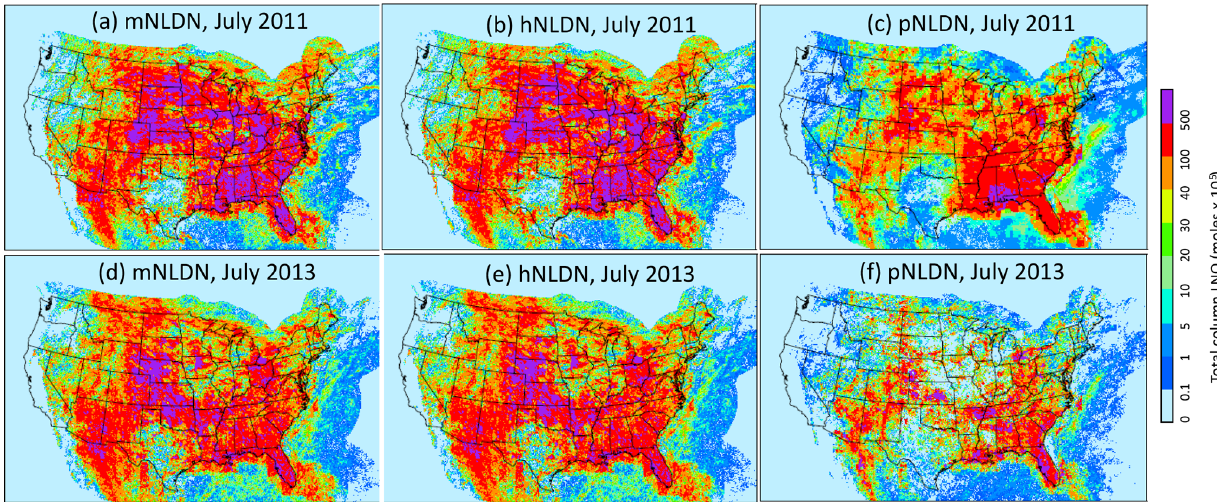
Figure 11. Spatial distribution of monthly column LNO with different LNO production schemes for July 2011 (a–c) and July 2013 (d–f) .